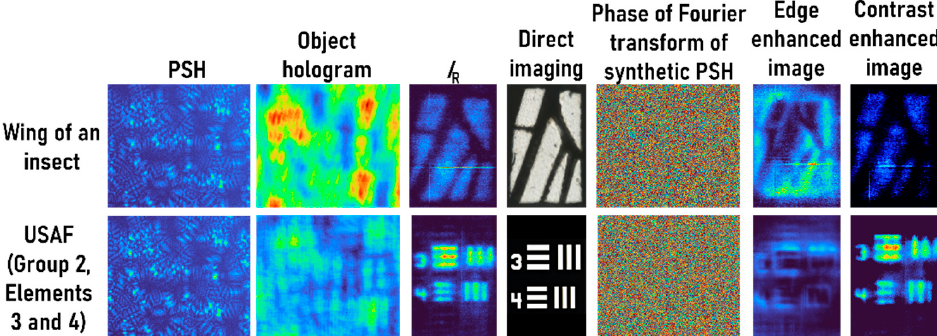
Figure 8. Images of the PSH, object hologram, reconstructed image ( I R ), direct imaging results, phase image of Fourier transform of synthetic PSH, edge and contrast-enhanced images for the wing of an insect and the USAF resolution target (Group 2, elements 3 and 4).